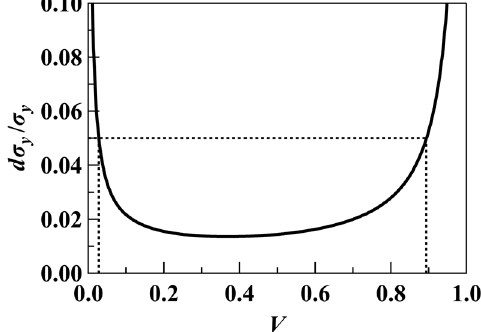
FIG. 6. Relative size measurement error as a function of fringe visibility V for a 0.01 visibility uncertainty. The region between the vertical dotted lines is the visibility range that gives d σ = σ < 0 . 05 . y y